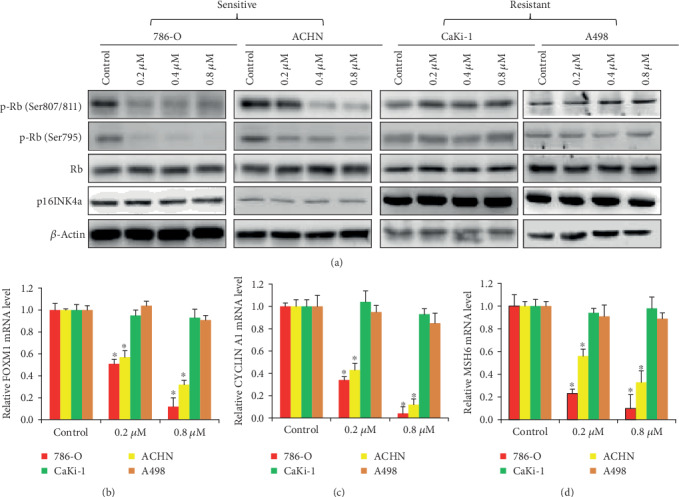
Differential effects of ribociclib on the CDK4/6-cyclin D-pRb signaling in RCC. (a) The representative western blot photo shows decreased and unchanged level of p-Rb at two phosphorylation sites in sensitive (IC50 < 200 nM) and resistant (IC50 > 800 nM) RCC cell lines, respectively. (b) The decreased and unchanged transcriptional level of E2F target genes: FOXM1, CCNE1, and MSH6 in RCC cell lines. Cells were treated with ribociclib for 24 hours prior to western blot and mRNA level analysis. ∗p < 0.05, compared to control.